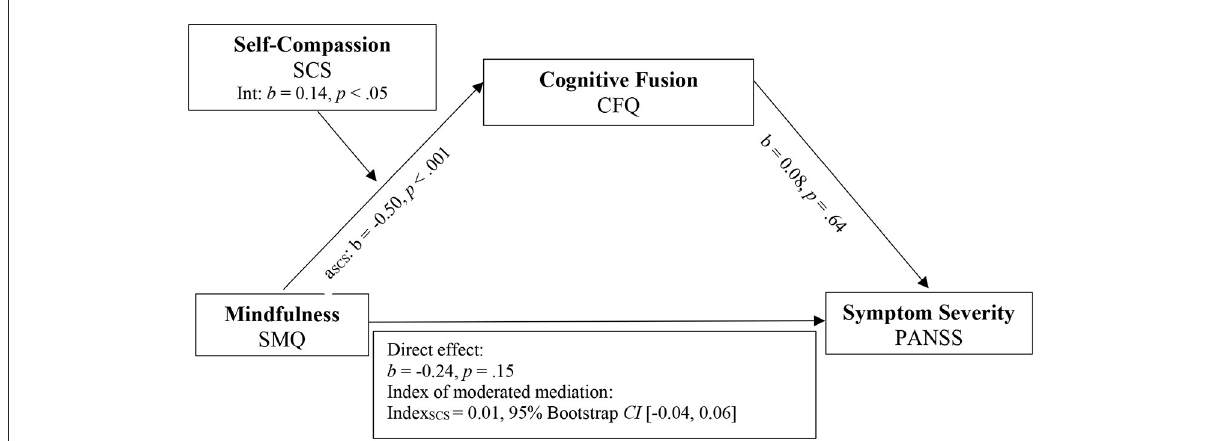
FIGURE2 Model 1. Moderated mediation model for mindfulness, self-compassion, cognitive fusion, and symptom severity. SMQ, Southampton Mindfulness Questionnaire; CFQ, Cognitive Fusion Questionnaire; PANSS, Positive and Negative Syndrome Scale; SCS, Self-Compassion Scale.